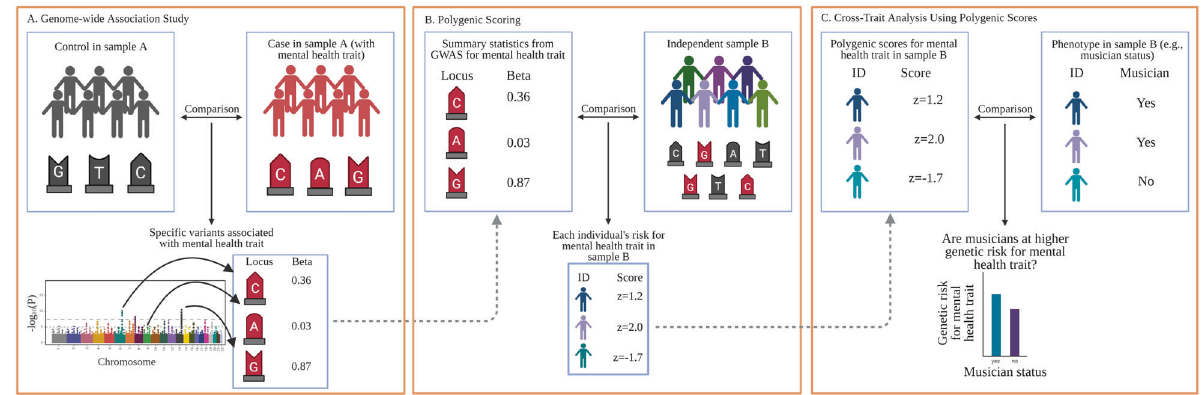
Fig. 4 Example of genome-wide association study (GWAS) and polygenic scores. A GWAS are conducted by examining whether individual genetic loci (i.e., single-nucleotide polymorphisms, or SNPs, depicted with G, A, C, and T labels within a sample (or meta-analysis) differentiate cases from controls. The example is based on a dichotomous mental health trait (e.g., major depressive disorder diagnosis), but GWAS can be applied to other dichotomous and continuous phenotypes, such as trait anxiety, musician status, or hours of music practice. Importantly, rather than examining associations on a gene-by-gene basis, GWAS identify relevant genetic loci using SNPs from across the entire genome (typically depicted using a Manhattan plot, such as that displayed at the bottom of A ). B After a GWAS has been conducted on a given trait, researchers can use the output to generate a polygenic score (sometimes called a polygenic risk score) in any new sample with genetic data by summing the GWAS effect sizes for each SNP allele present in a participant ’ s genome. An individual with a z = 2.0 would have many risk SNPs for that trait, whereas an individual with z = − 2 would have much fewer risk SNPs. C Once a polygenic score is generated for all participants, it can be applied like any other variable in the new sample. In this example, researchers could examine whether musicians are at higher (or lower) genetic risk for a speci fi c disorder. Other more complex analyses are also possible, such as examining how polygenic scores interact with existing predictors (e.g., trauma exposure) or polygenic scores for other traits to in fl uence a phenotype or predict an intervention outcome. Created with